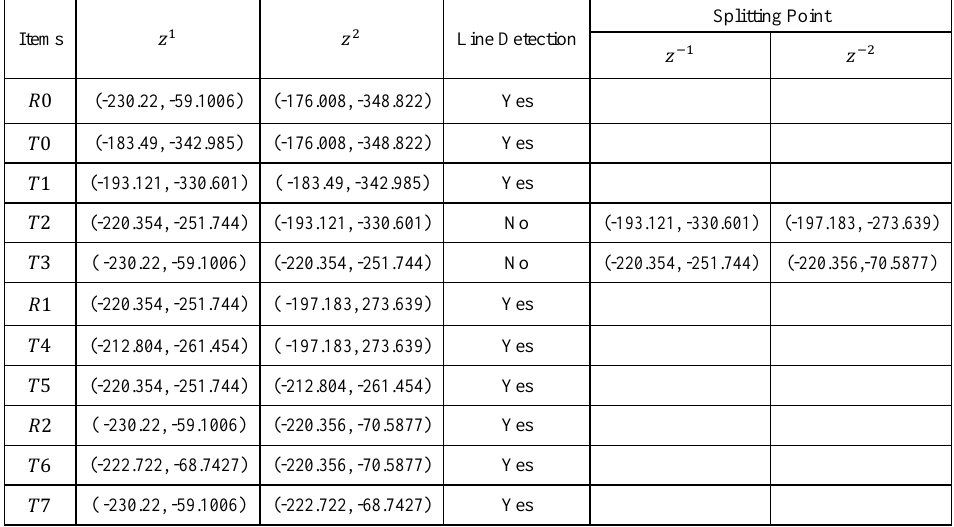
Table 1. Detailed information for the nodes in the search tree for example 5.1